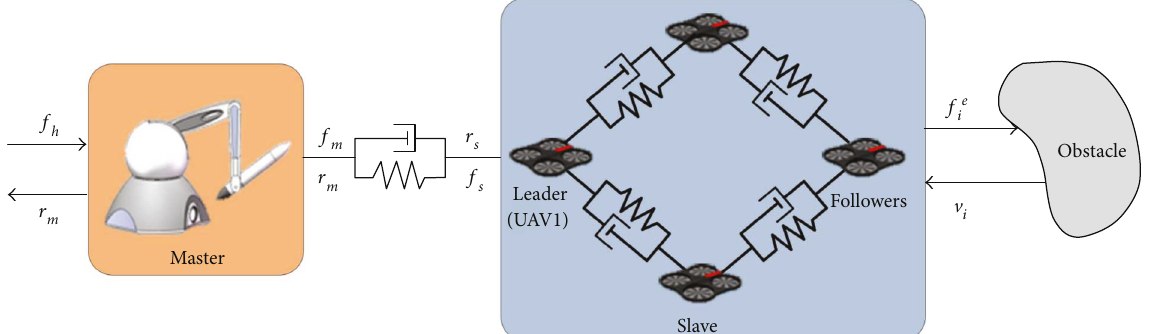
Figure 3: The overall bilateral teleoperation